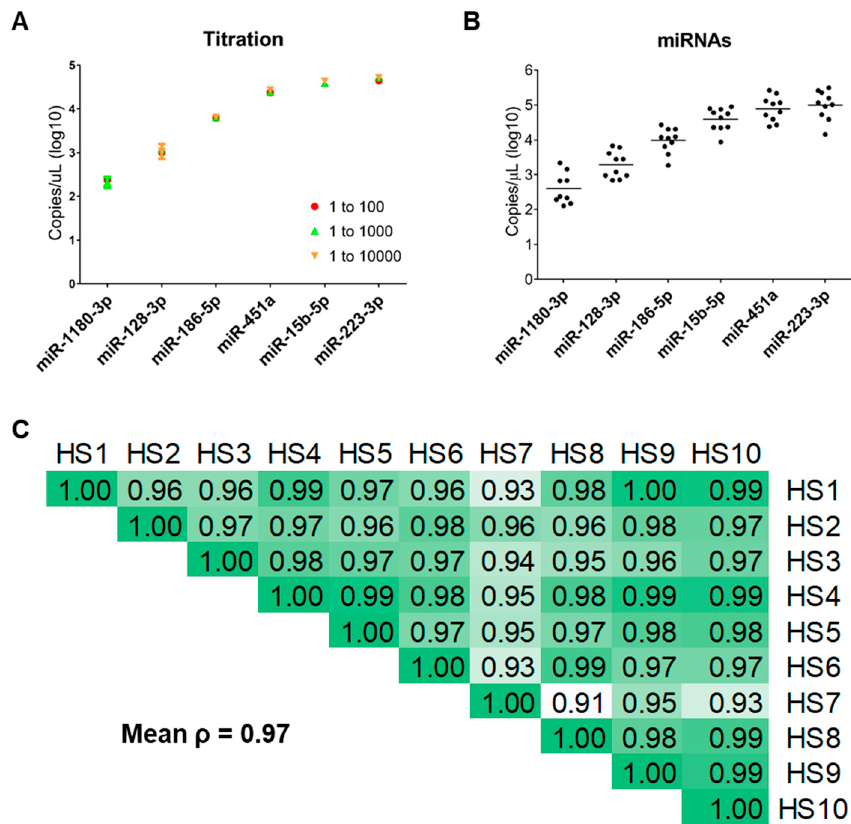
Figure 2. Digital PCR settings for miRNA detection in human plasma without RNA extraction. ( A ) Expression levels of miR-1180-3p, miR-128-3p, miR-186-5p, miR-451a, miR-15b-5p, and miR-223-5p at different dilutions in a plasma sample without RNA extraction. The data are expressed as Log10 (miRNA copies/ µ L of the sample), and error bars represent the 95% confidence interval. Each color and shape indicate the different dilution conditions. ( B ) Dot plot depicting the expression levels of miR-1180-3p, miR-128-3p, miR-186-5p, miR-451a, miR-15b-5p, and miR-223-5p in ten plasma samples without RNA extraction. The data are expressed as Log10 (miRNA copies/ µ L of the sample). Horizontal bars represent mean values. ( C ) Correlation matrix conducted on the expression of levels of miR-1180-3p, miR-128-3p, miR-186-5p, miR-451a, miR-15b-5p, and miR-223-5p in no-extraction samples from ten healthy subjects (HS). Green-shade intensity is directly proportional to the mean Pearson correlation coefficient.